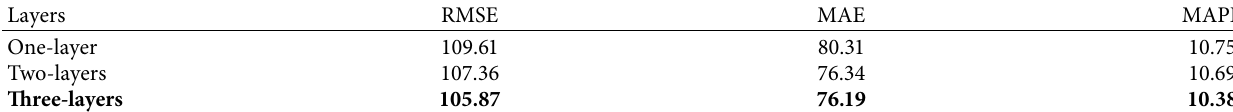
Table 3: Compare evaluation indicators in the machine learning model.